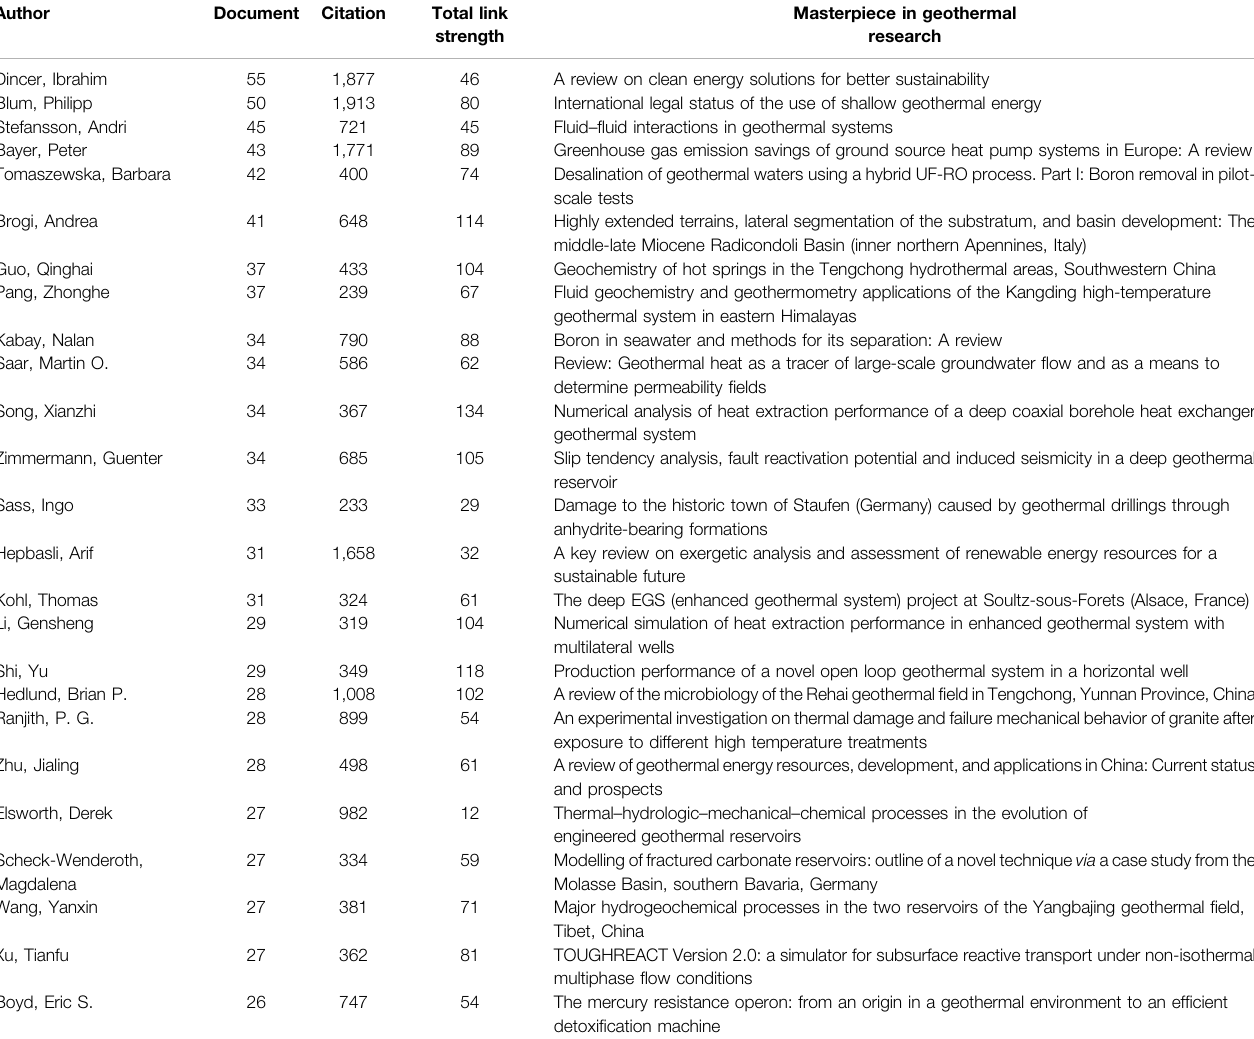
TABLE 2 | Top 25 authors with publications in geothermal